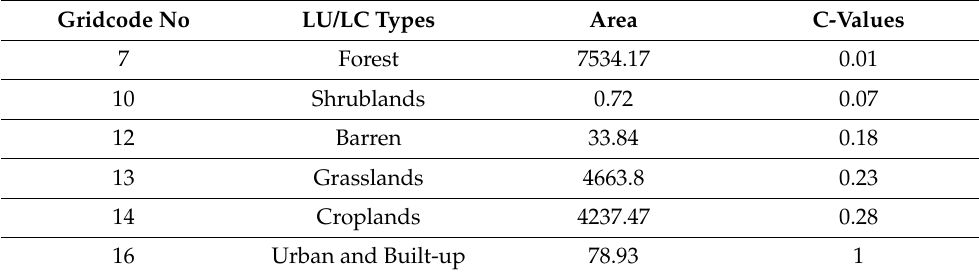
Table 3. C values for different LULC